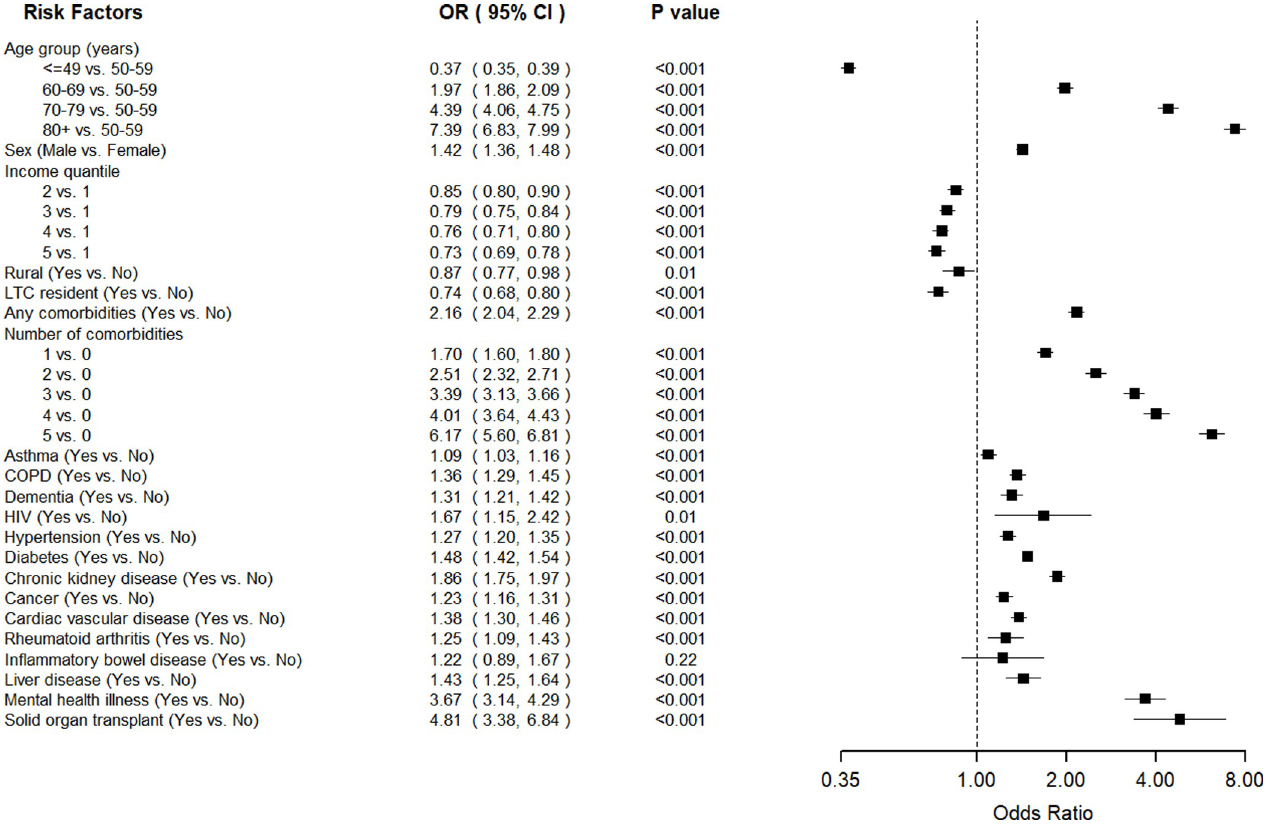
Fig 4. Associations of demo-socio-economic characters and comorbidities with the compositive disease severity outcome that includes all-cause 30-day mortality and hospitalization from logistic regression models. Lines represent 95% confidence interval. The hazard ratios of whether having any comorbidities, and number of comorbidities were calculated based on separate multivariable Cox models that included age, sex, income quantile, rural and LTC resident.